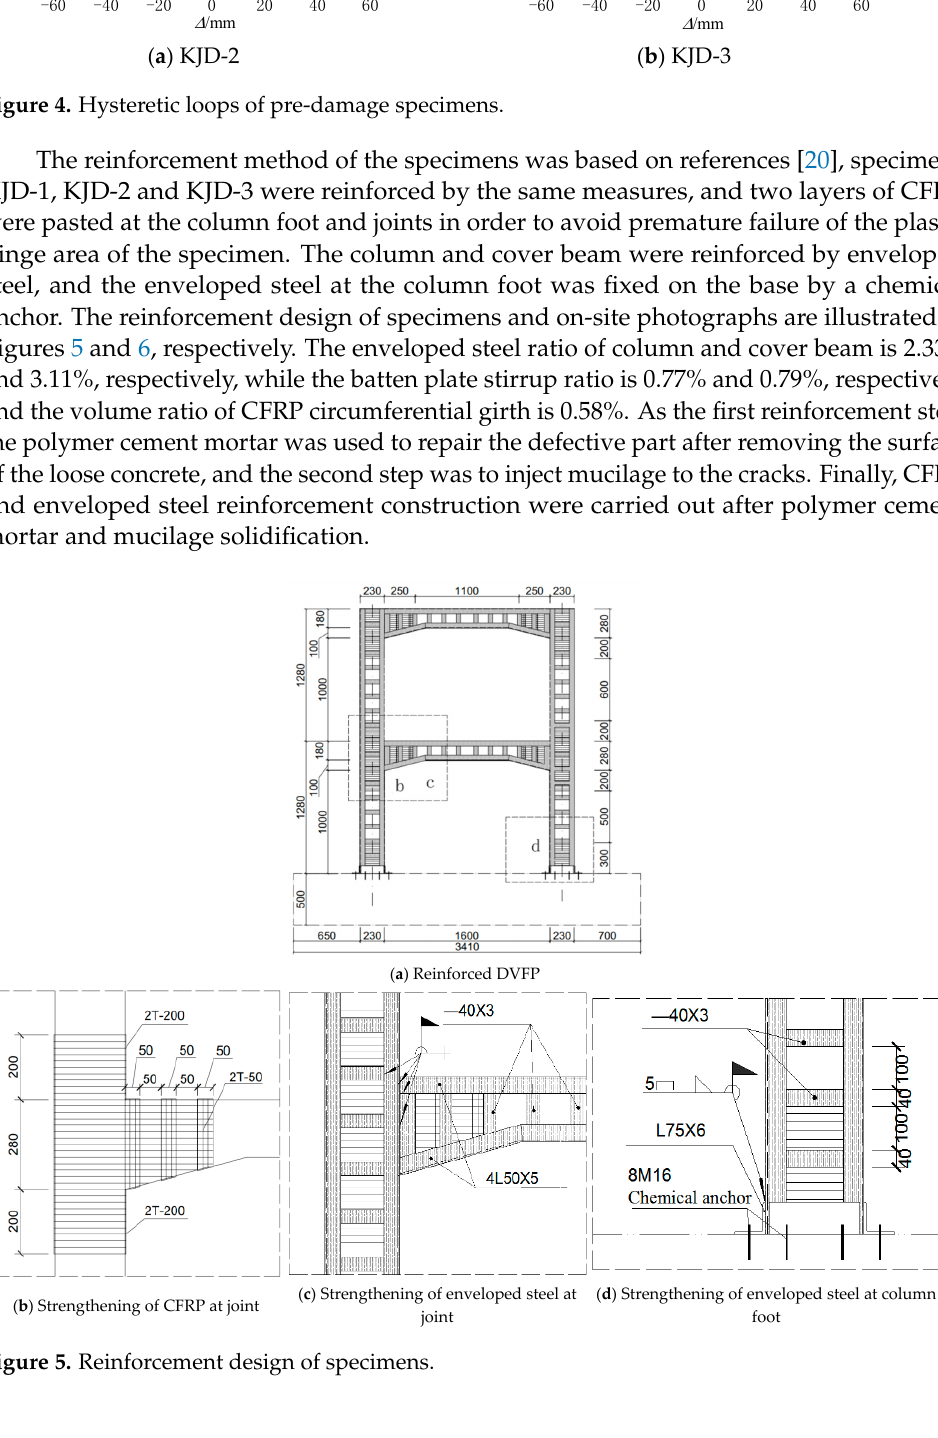
Reinforcement design of